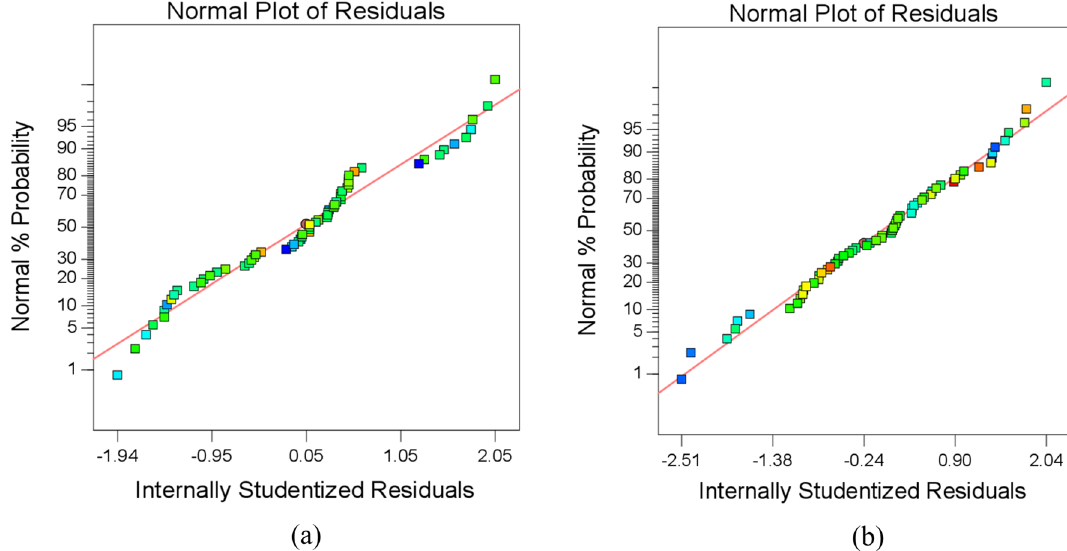
Figure 7. Residuals plots ( a ) MR and ( b ) R a